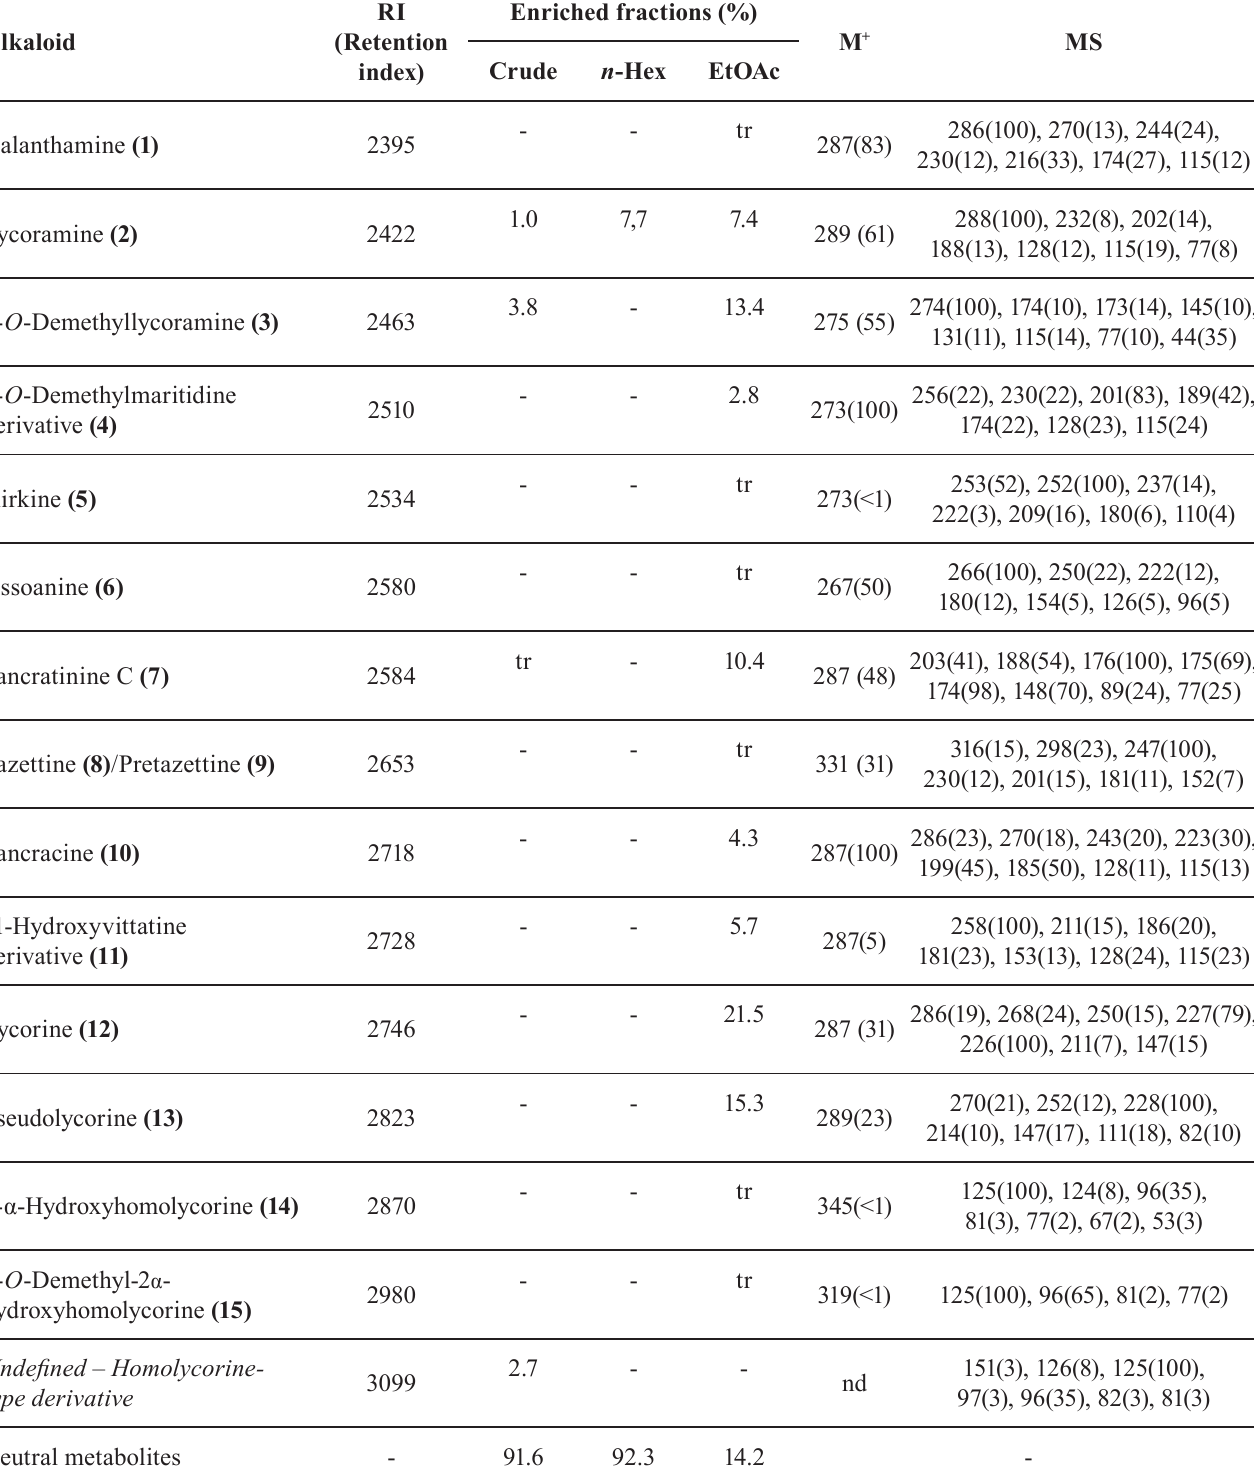
Crude: crude methanolic extract, n -Hex: n -hexane extract, EtOAc: ethyl acetate extract; tr: traces (less than 1% of TIC); nd: not detected; neutral metabolites: terpenes, fatty acids, sterols, among